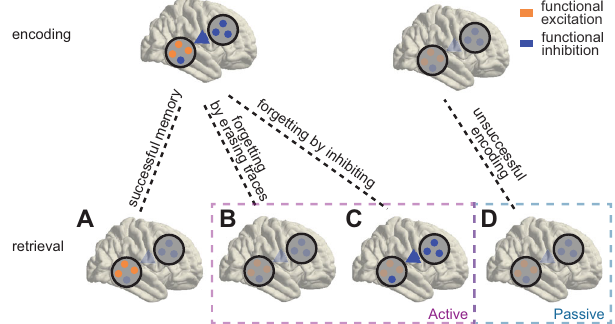
Fig. 1 Reading memory traces via encoding-retrieval similarity. During encoding, stimulus-speci fi c patterns of functional inhibition and activation are modi fi ed in a context-dependent manner. These patterns reoccur during successful memory retrieval, resulting in high encoding-retrieval similarity (ERS; A ). Active forgetting may result from either erasing the traces of previously modi fi ed connections ( B ; low ERS) or from selective modi fi cation of patterns of functional inhibition ( C ; high ERS, but for inhibition patterns). If encoding is not successful (i.e., memory traces are not modi fi ed) ERS values will be low ( D